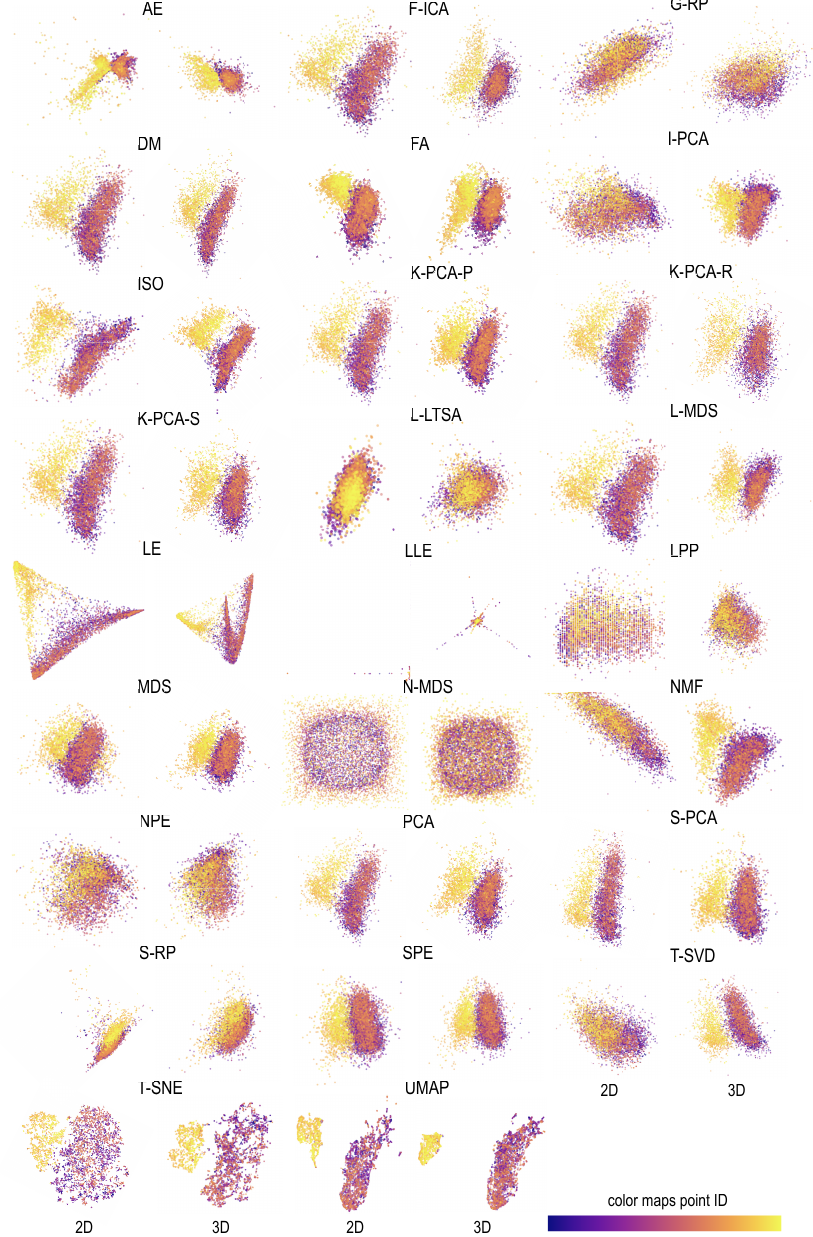
Figure 3. Visual comparison of 2D vs. 3D projections for the task of identifying separated data clusters, Wine dataset (Section